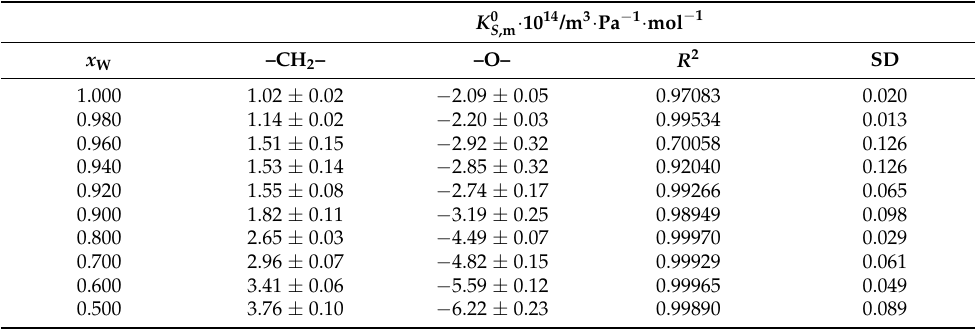
R 2 is the regression coefficient. SD is the standard deviation. The uncertainty of the mole fraction x W is equal to ± 1 · 10 − 3 . Table 12. The average effect of interaction between the –CH 2 – or –O– group and molecules of the DMF + W mixed solvent in K 0 at 298.15 S ,m